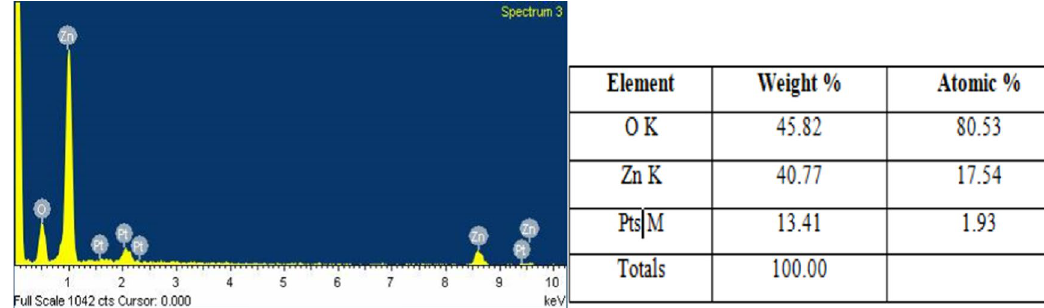
Fig. 10 EDX graph and compositionof ZnO